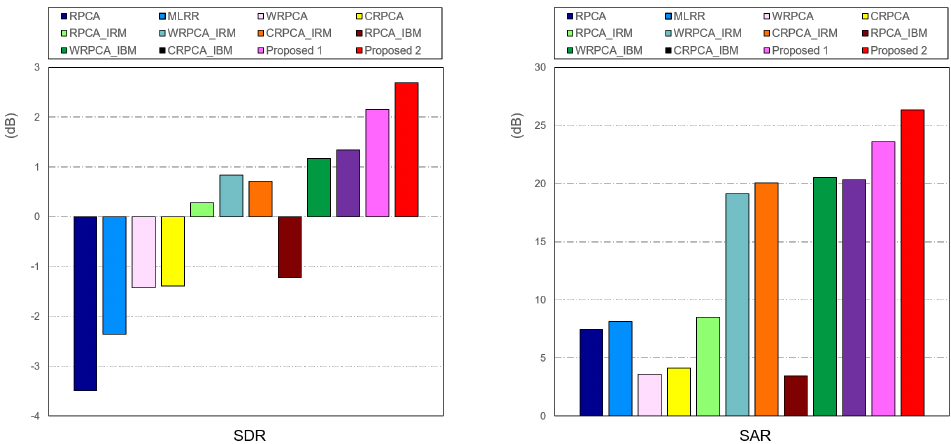
Figure 6. Comparison of SVS on ccMixter dataset for each of the following: RPCA, MLRR, WRPCA, CRPCA, RPCA using IRM, WRPCA using IRM, WRPCA using IRM, RPCA using IBM, WRPCA using IBM, CRPCA using IBM, Proposed 1, and Proposed 2,